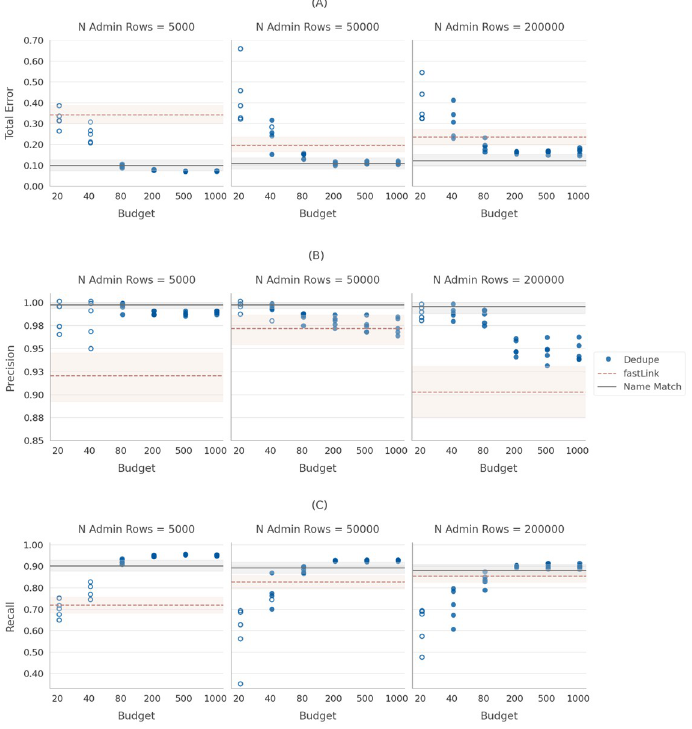
Fig 4. Performance of dedupe under the deduplication framework, sample size 150,000. A: Total error. B: Precision. C: Recall.